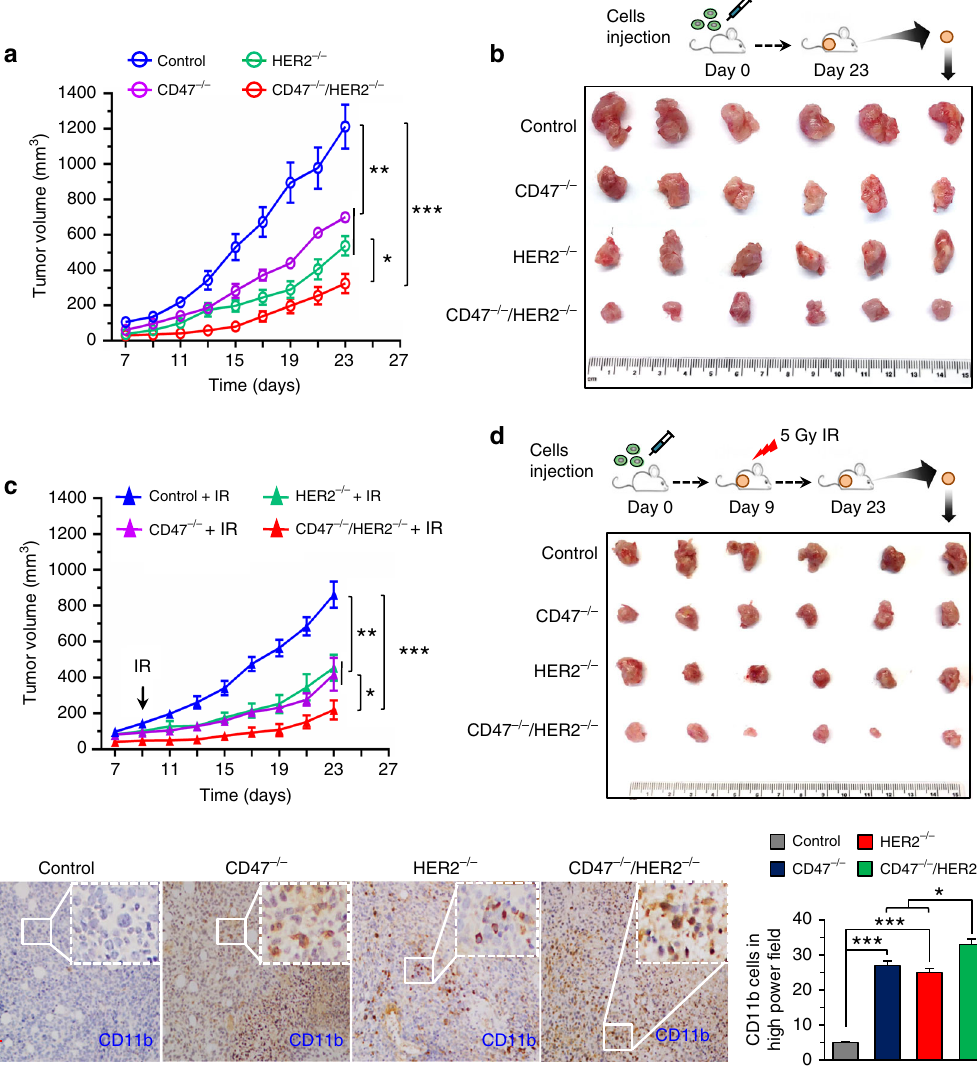
Fig. 5 Radiosensitization is maximized in mouse breast tumors carrying CD47 − / − /HER2 − / − status. a Growth rate of mouse breast tumors generated with radioresistant 4T1/C2 cells with CD47 − / − , HER2 − / − , or CD47 − / − /HER2 − / − . b Representative images of tumors at the end of experiments. c Repeated experiment of a with a single dose IR (5 Gy) at day 9 and representative images of the tumor at the end of experiments shown in d ; in a and c , n = 6, mean ± SEM, * P < 0.05, ** P < 0.01, *** P < 0.001. e Left, representative IHC images of CD11b + macrophages in CD47 − / − , HER2 − / − , CD47 − / − / HER2 − / − tumors; scale bar = 100 µ m; right, quantitation of CD11b + macrophages ( n = 4, * P < 0.05, *** P <